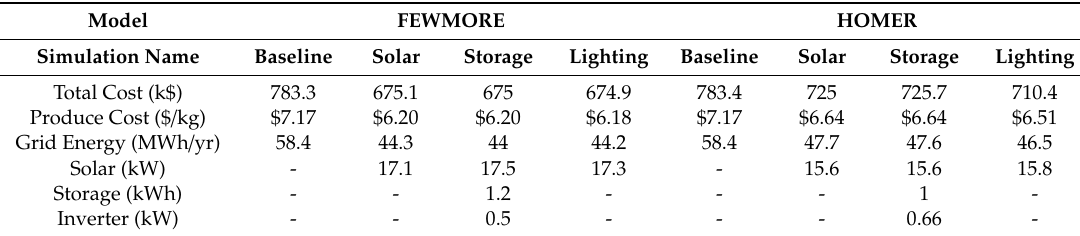
Table 3. Summary of results using the FEWMORE (Food-Energy-Water Microgrid Optimization with Renewable Energy) Model compared with HOMER for simulations, using the collected container farm data ( Base Case ). Total cost objectives were ~4–7% higher and solar capacities were ~9% lower in HOMER compared to